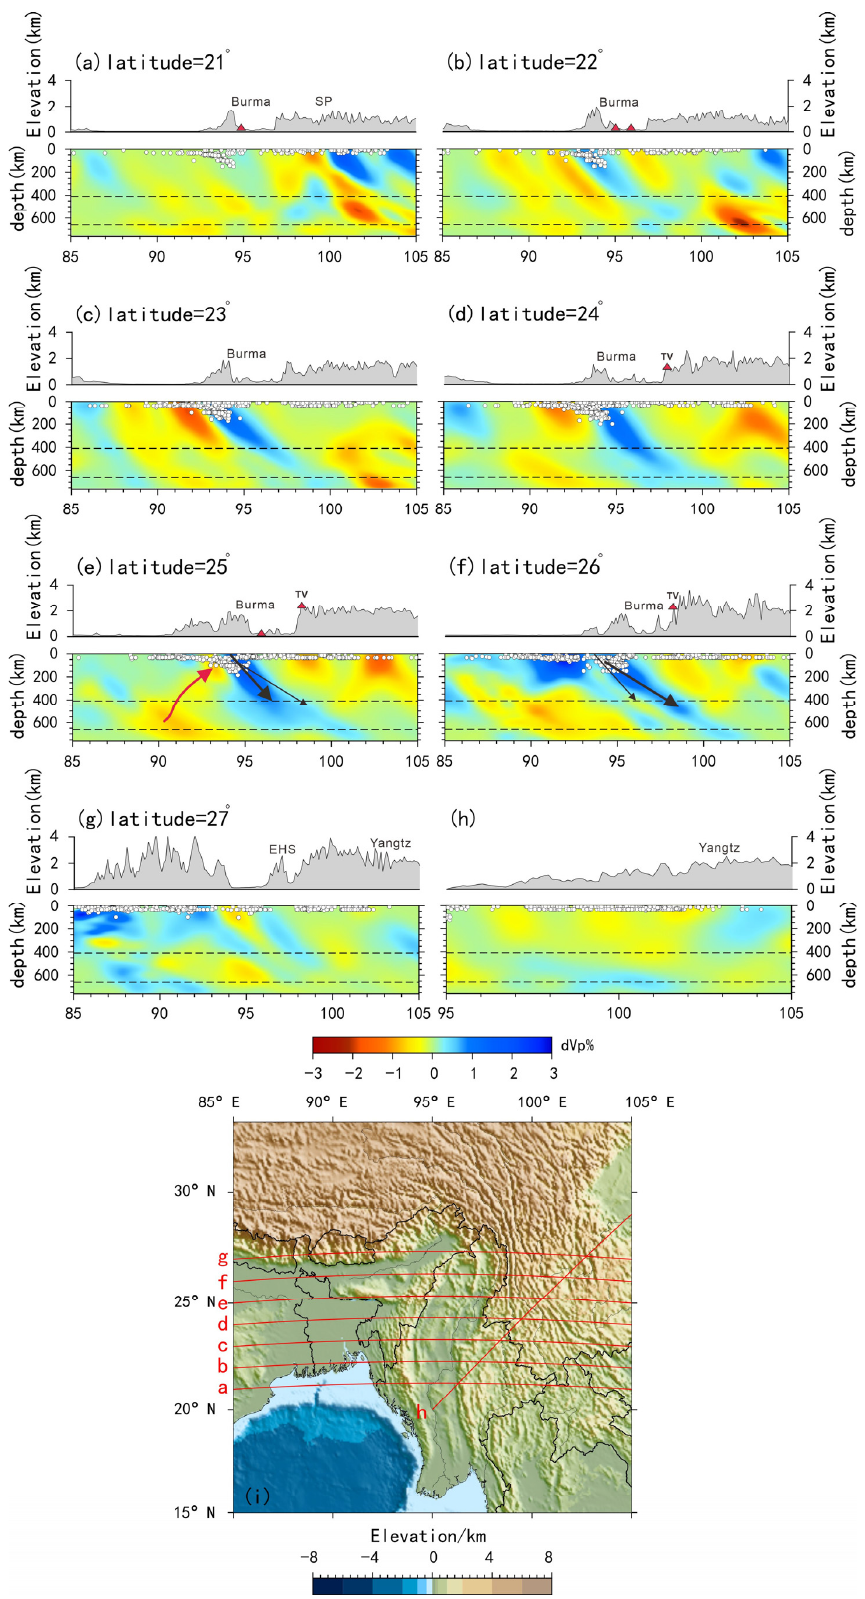
Figure 8. ( a – g ) Along the vertical cross-section through Myanmar shown in the ( i ) map; ( h ) through the Yangtze craton plate. The white dots on the profile indicate earthquakes within 30 km of the survey line, and the red triangle volcano symbol indicates volcanoes within 50 km.